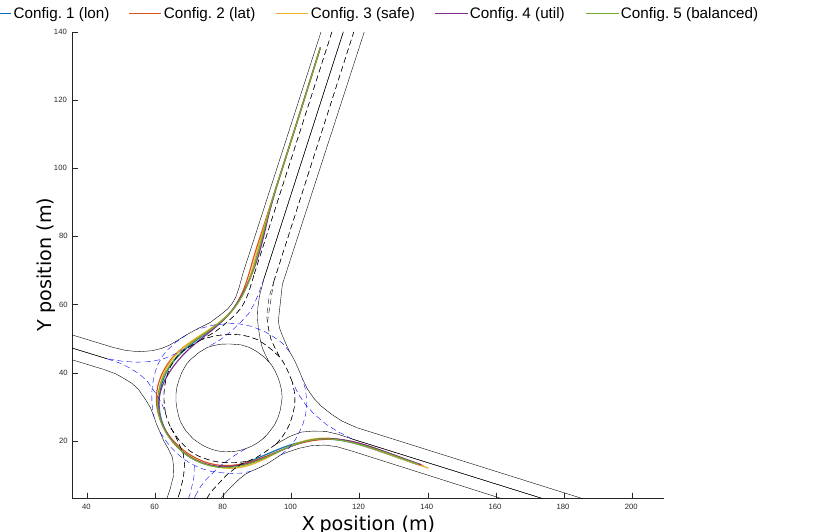
Figure 20. Final trajectories for the different weight configurations in the simulation environment.